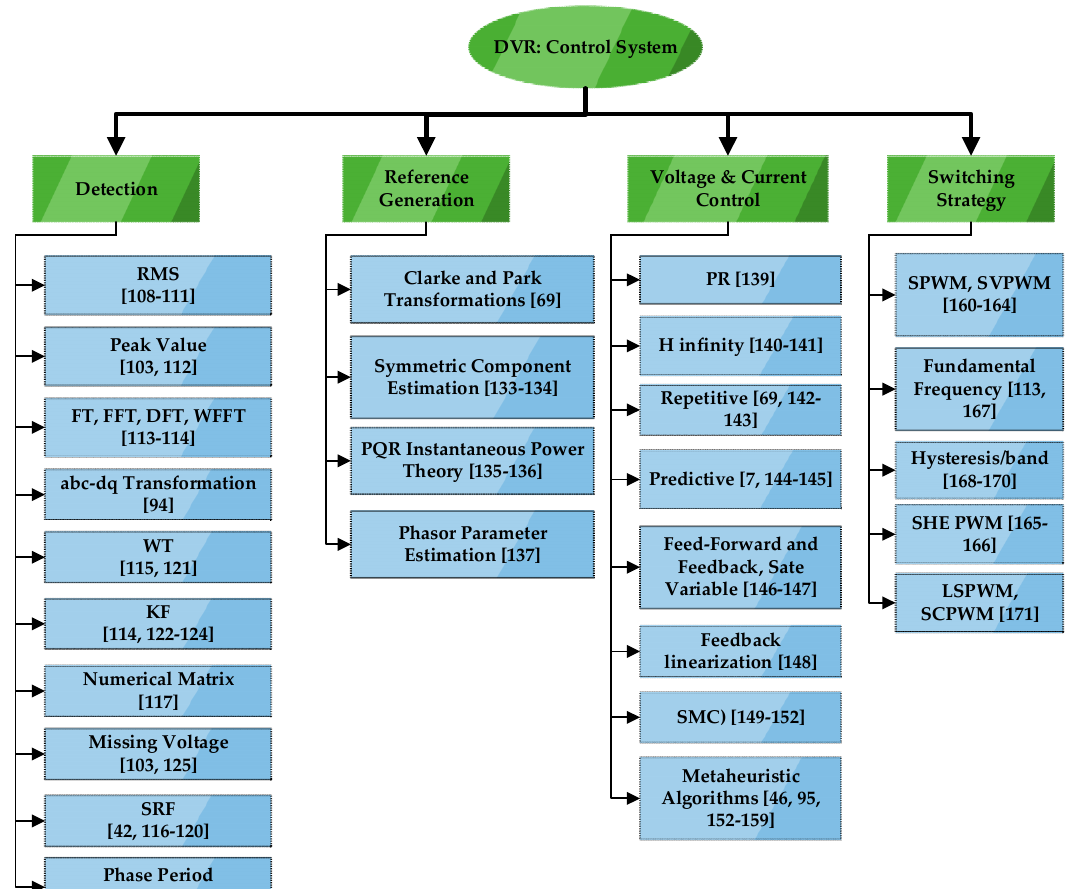
Figure 9. Different stages of the control unit in the DVR. Based on data from [7,42,69,94–170].